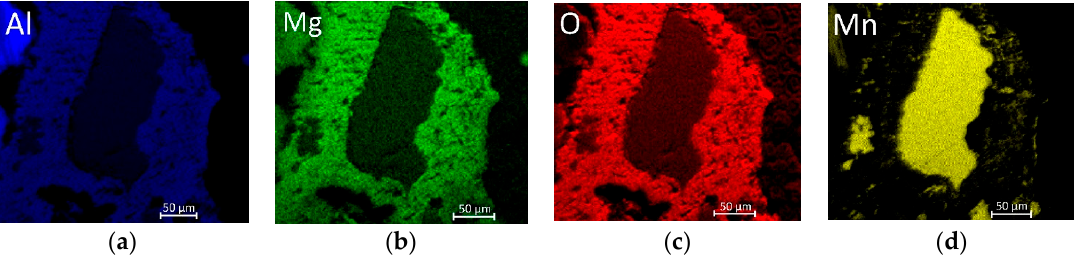
Figure 10. X-ray maps by EDS of manganese particle ( a ) aluminum, ( b ) magnesium, ( c ) oxygen, and ( d ) manganese.